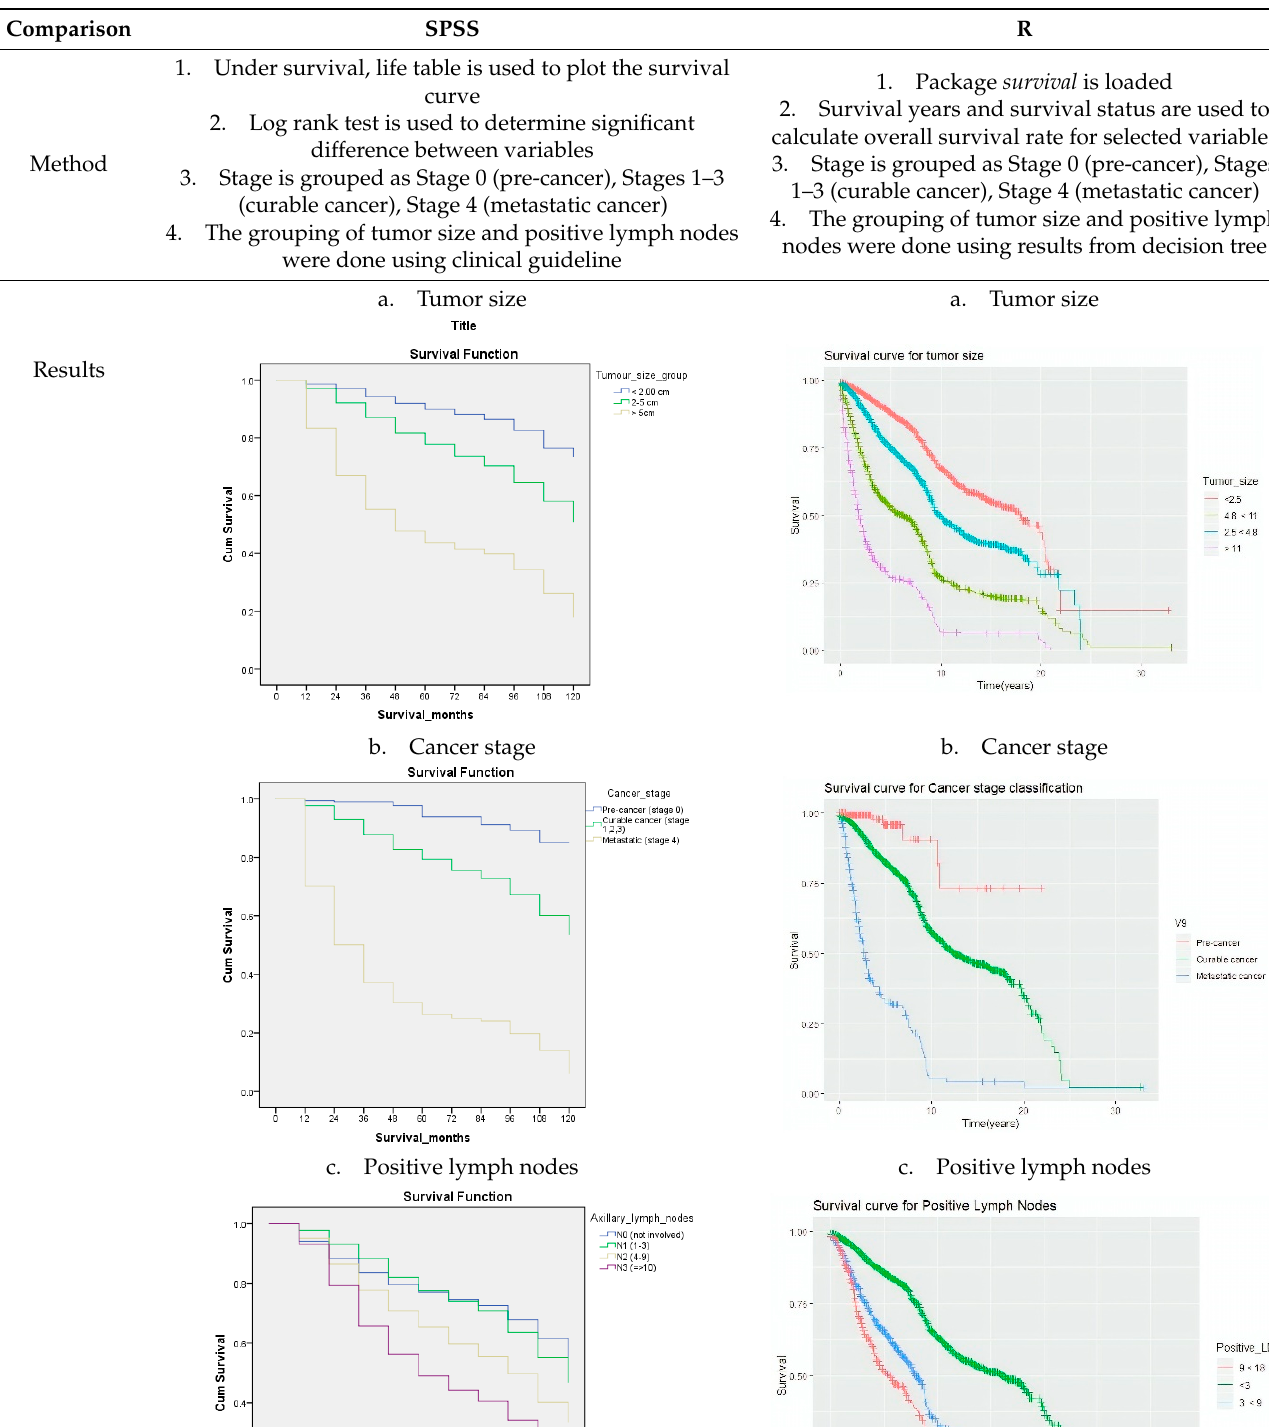
Table 5. Survival analysis comparison using SPSS and R.